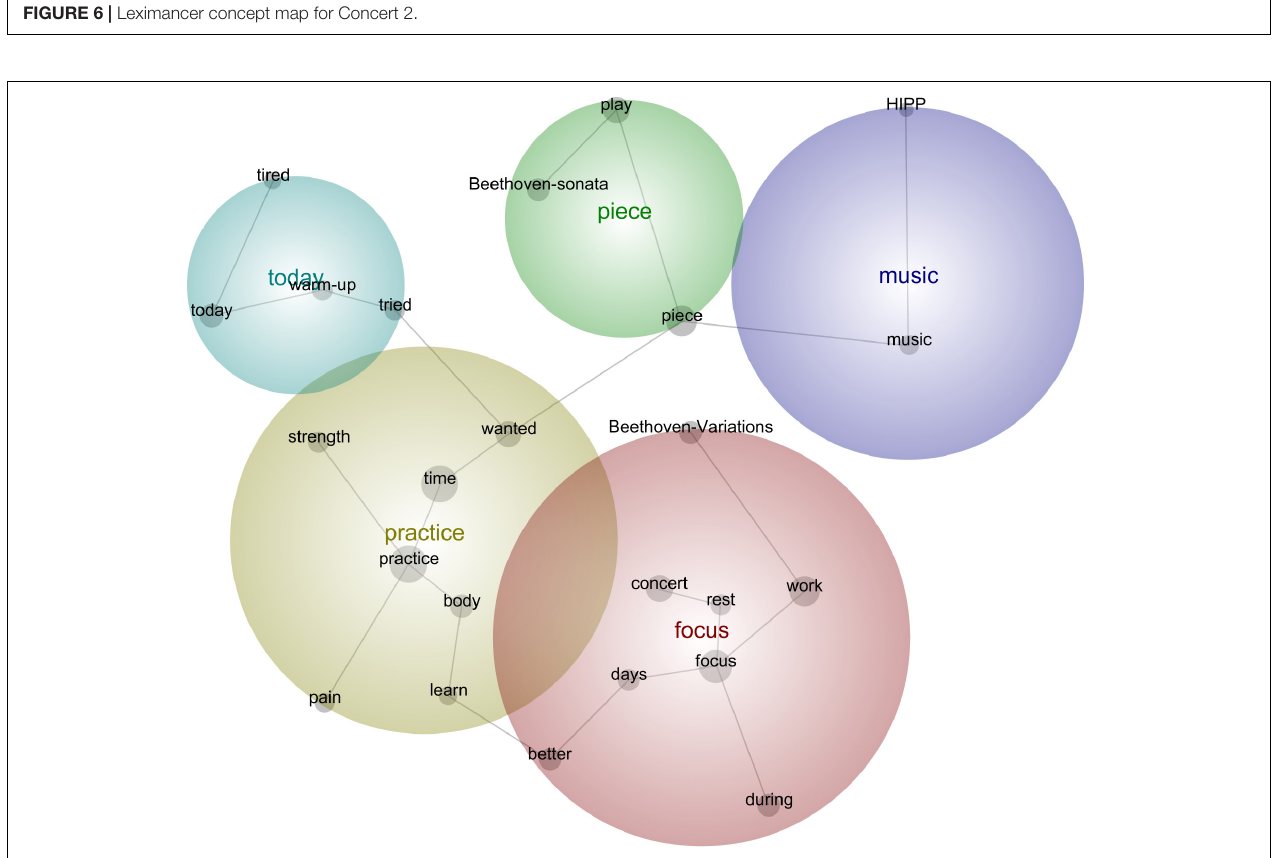
FIGURE 7 | Leximancer concept map for Concert